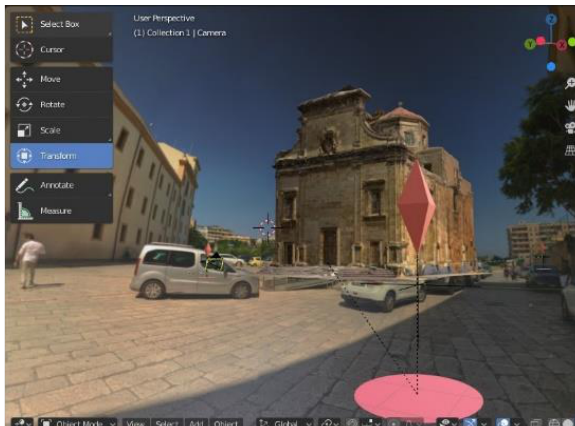
Figure 13. Visualization of the result obtained from the combination of a sphere and the 3D